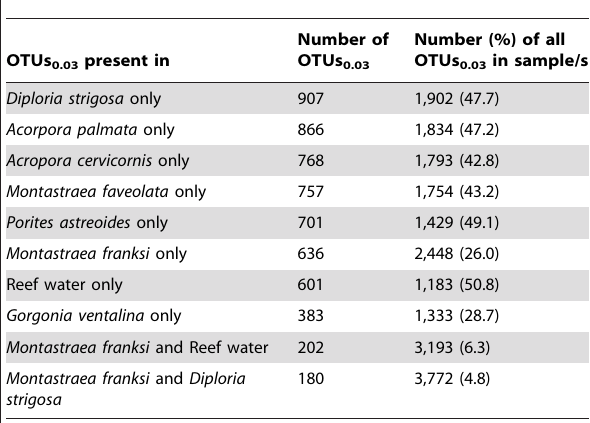
Table 2. Top 10 ranked OTU 0.03 distribution possibilities.